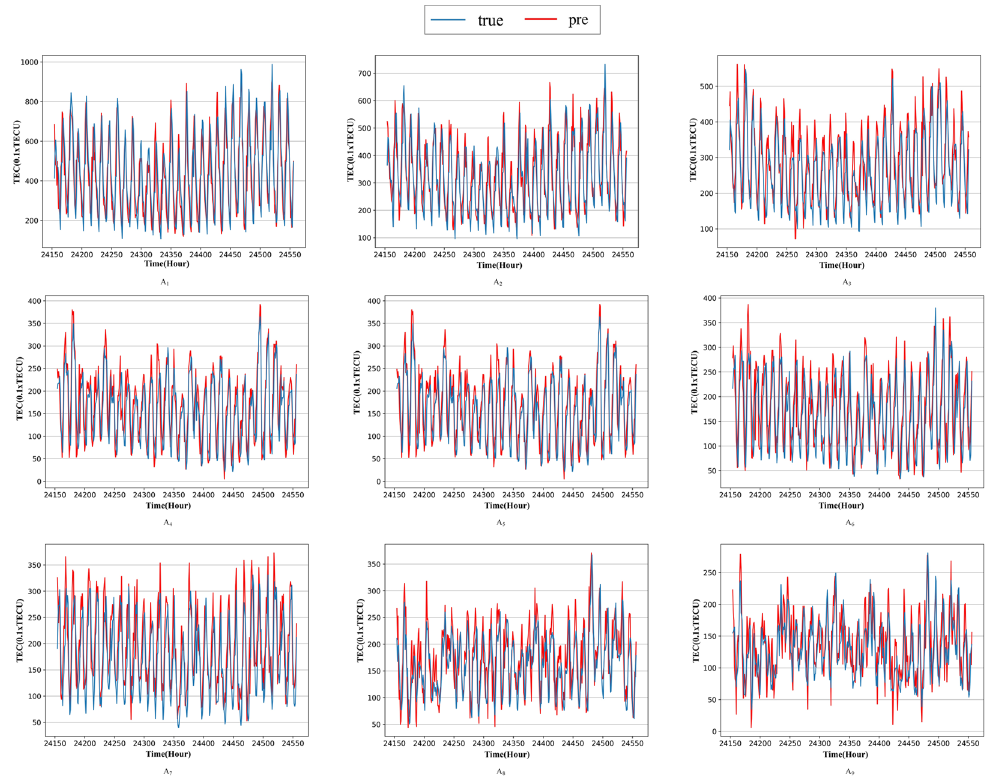
Figure 12. Prediction effect of HSA periods in 9 regions in Figure 1.